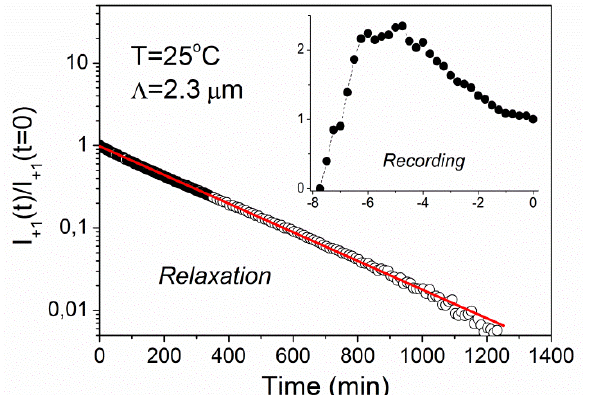
Figure 4. Time dependence of diffracted intensity during recording (inset) and relaxation for a grating with the period of Λ = 2.3 μ m at T = 25 ° C. The solid line is a fit to single-exponential